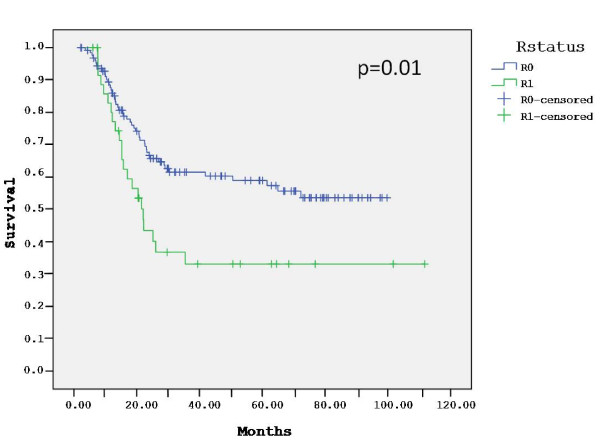
Overall survival by surgical margins.